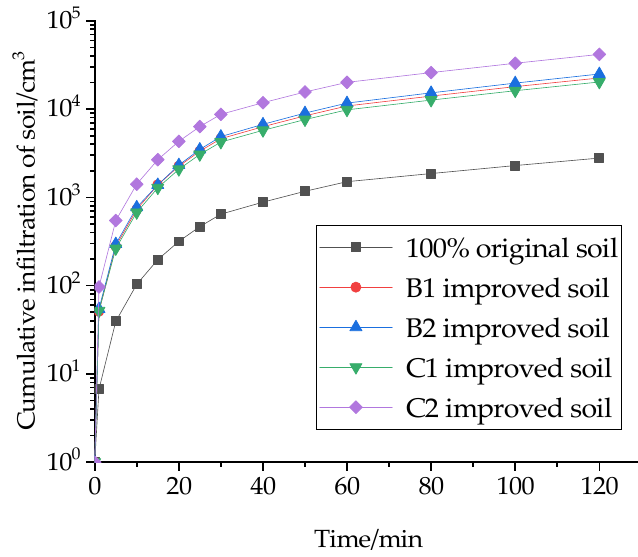
Figure 4. Effect of ameliorants on cumulative soil infiltration.